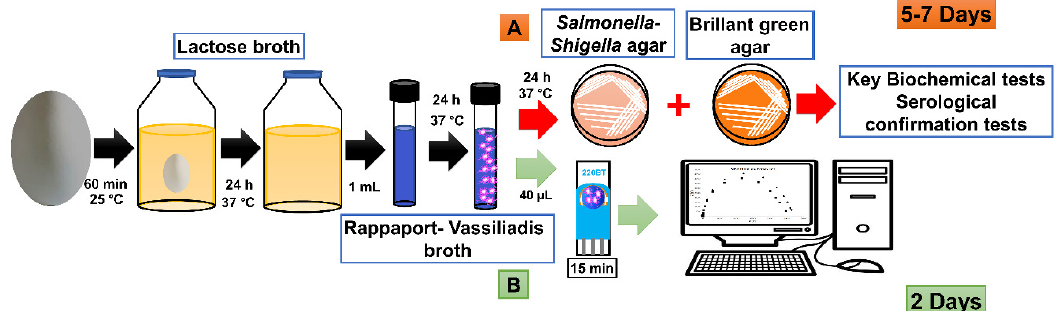
Figure 2. Analysis scheme for Salmonella spp. detection. The sample is placed for pre-enrichment in lactose broth (LB) and enrichment in Rapaport-Vassiliadis broth (RVB). ( A ) Analysis of presumptive colonies, employing the microbiology method, involving inoculation in solid media ( Salmonella - Shigella and brilliant green agars). ( B ) Analysis employing the biosensor, using 40 μ L of